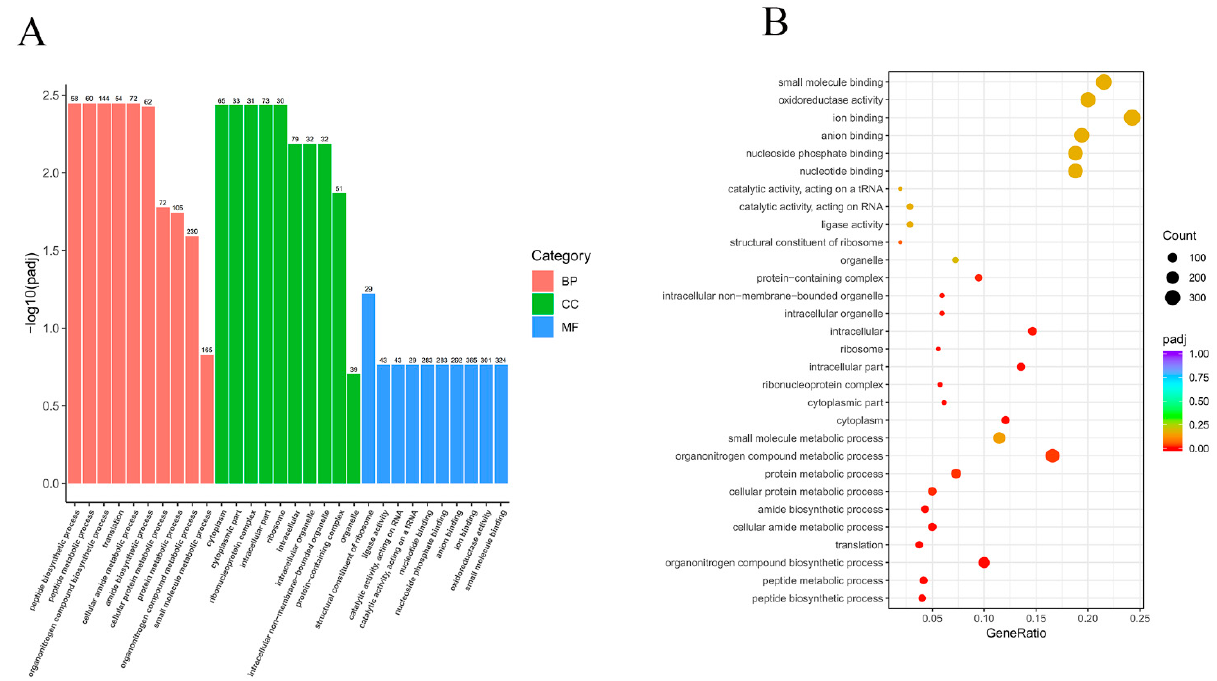
Figure 3. ( A ) Histogram of GO functional enrichment analysis based on DEGs. ( B ) Scatter plot of GO functional enrichment analysis based on DEGs.